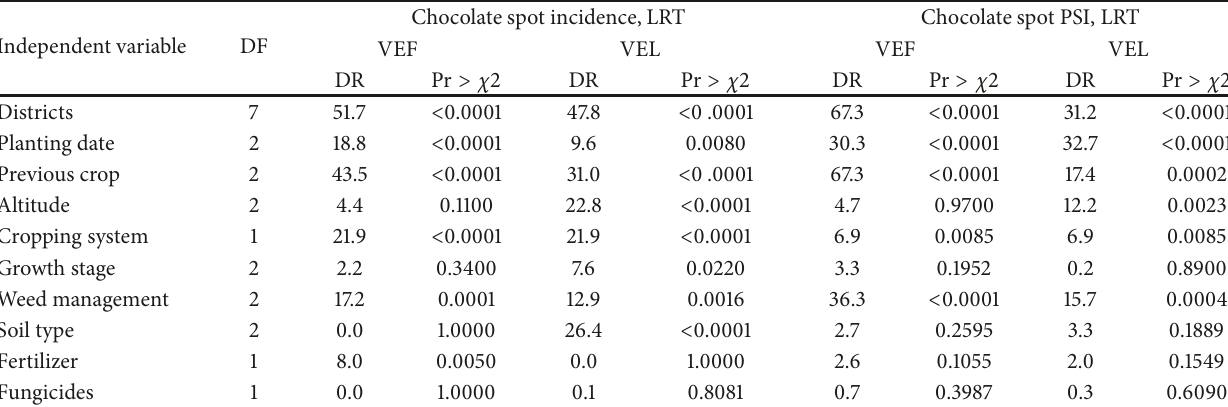
Table 4: Independent variables used in logistic regression modeling of chocolate spot incidence and percentage severity index (PSI) and likelihood ratio test (LRT) for ten variables entered first and last into a model.